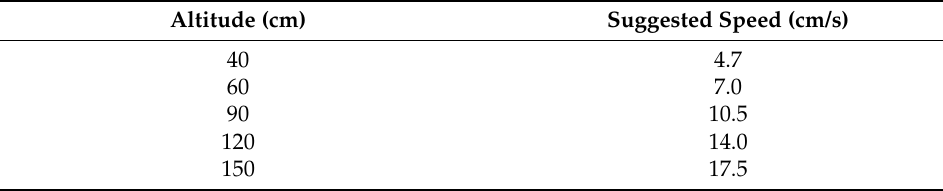
Figure 8. Minimum, suggested, and maximum speed for different altitude. Table 3. Determining speed (cm/s) for various overlapping % at different altitude.